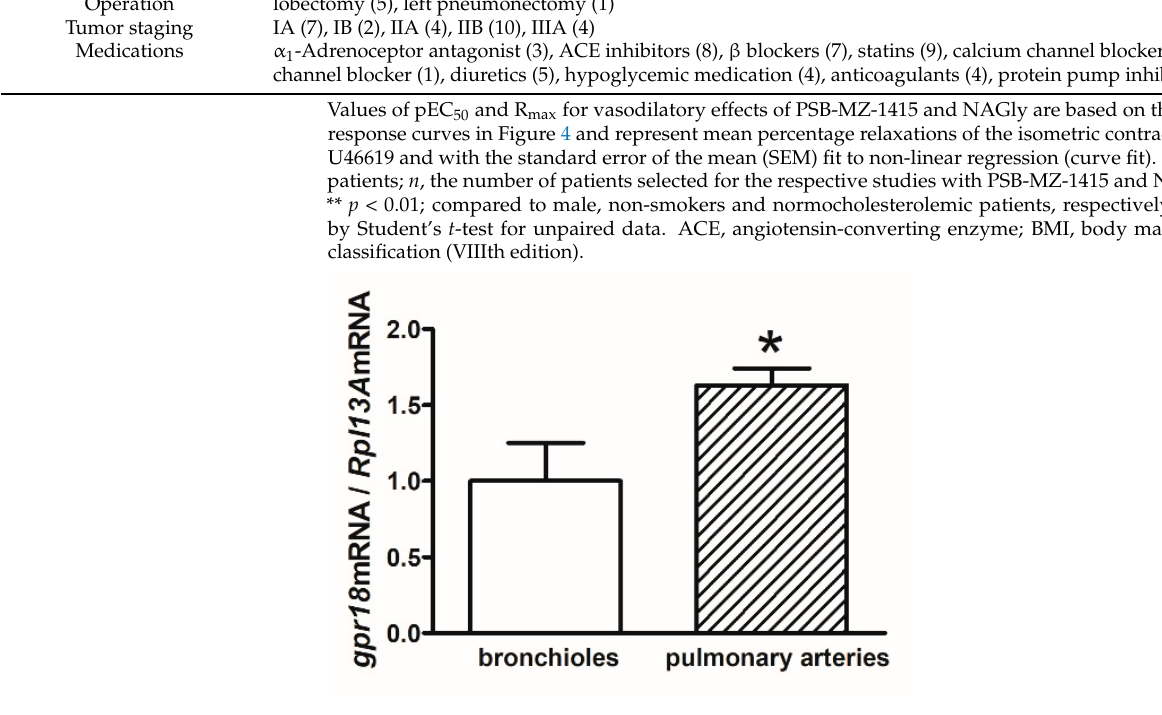
Figure 5. Relative mRNA expression level of gpr18 evaluated by real-time qPCR assay in isolated human bronchioles and pulmonary arteries. The RNA isolated from bronchioles was used as the control, and its expression was set 1.0. Results are shown as a relative fold change in mRNA expression in comparison to control. The results are presented as the mean ± SEM of 6 tissue samples. * p < 0.05.